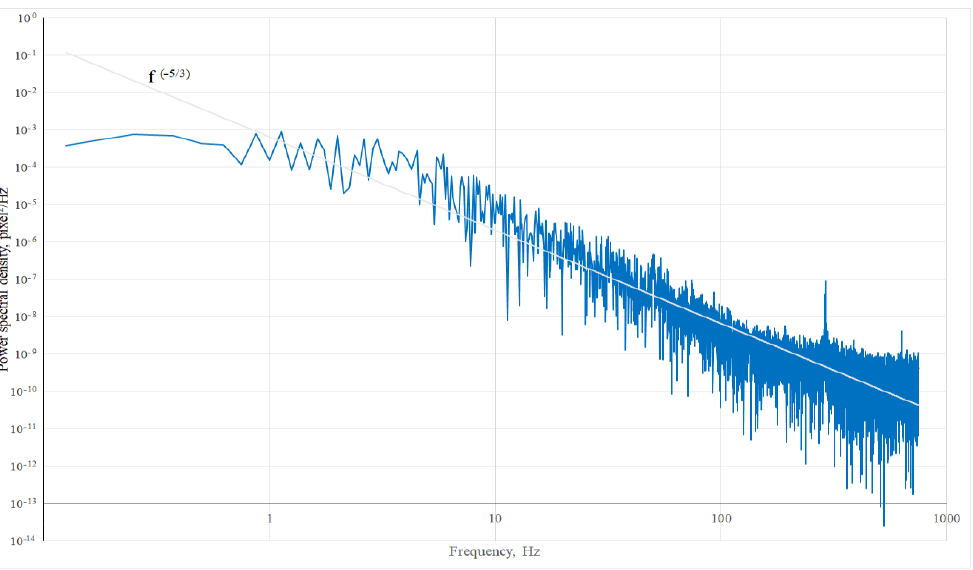
Figure 6. Spectral power density of the oscillation of the X coordinate of the WFS lens array focal